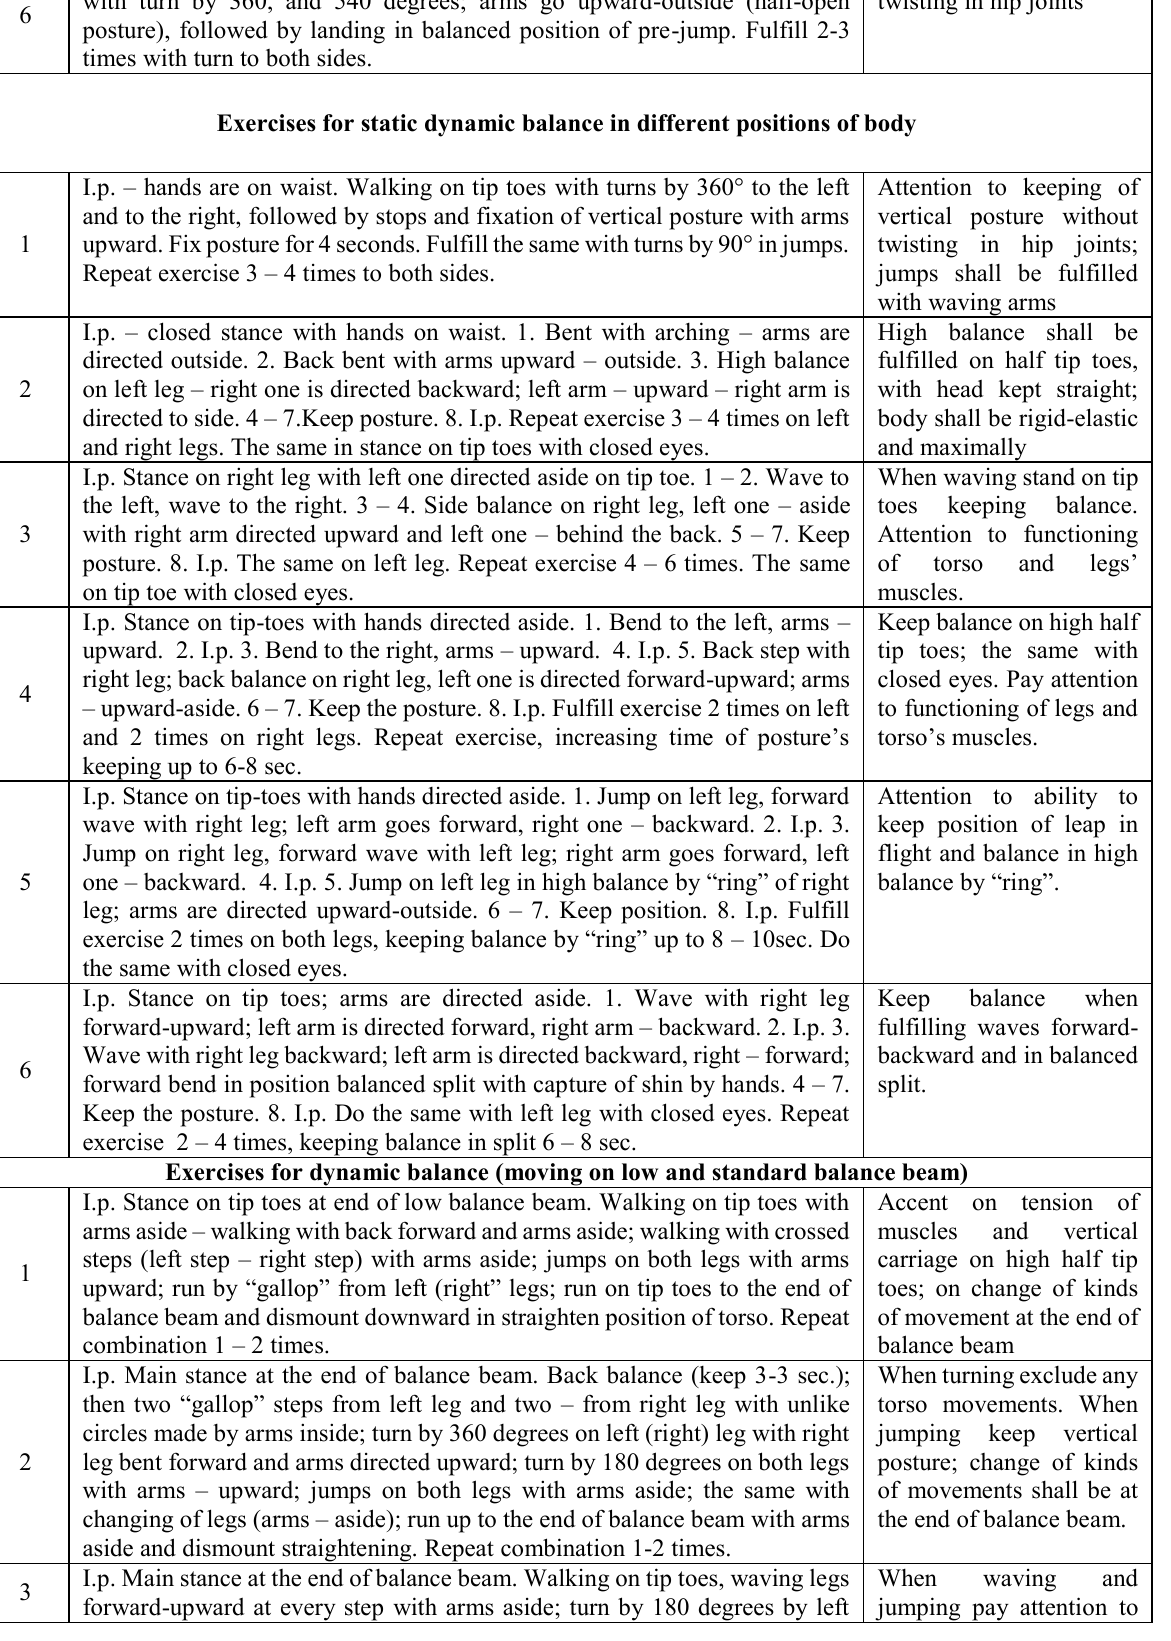
Accent on tension of muscles and vertical carriage on high half tip toes; on change of kinds of movement at the end of balance beam When turning exclude any torso movements. When jumping keep vertical posture; change of kinds of movements shall be at the end of balance beam. When waving and jumping pay attention